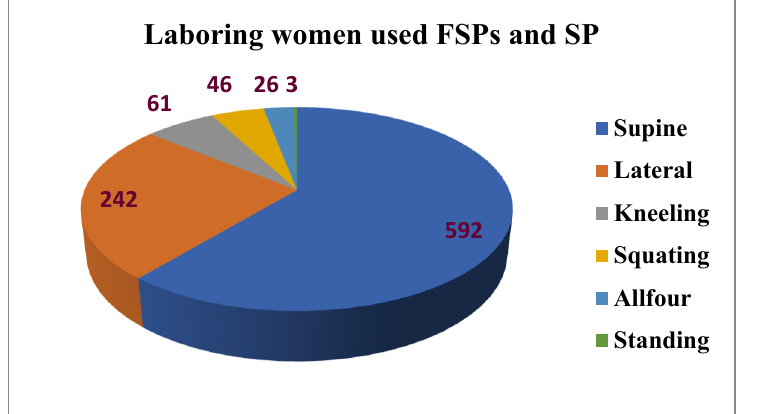
Figure 2. Number of the study participants who used the flexible sacrum positions and supine po- sition, in Amhara public Health facilities, 2019.